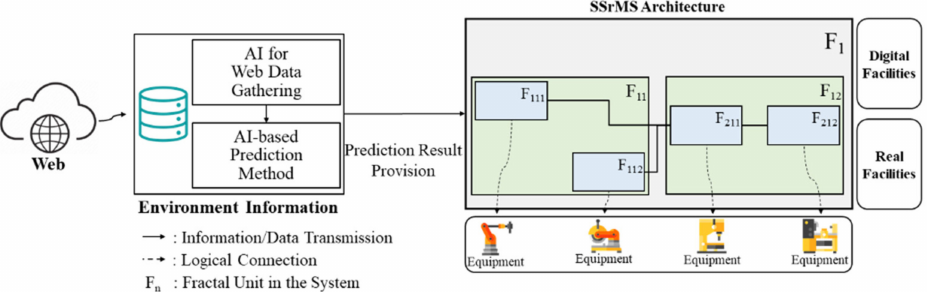
Figure 11. Environment information in